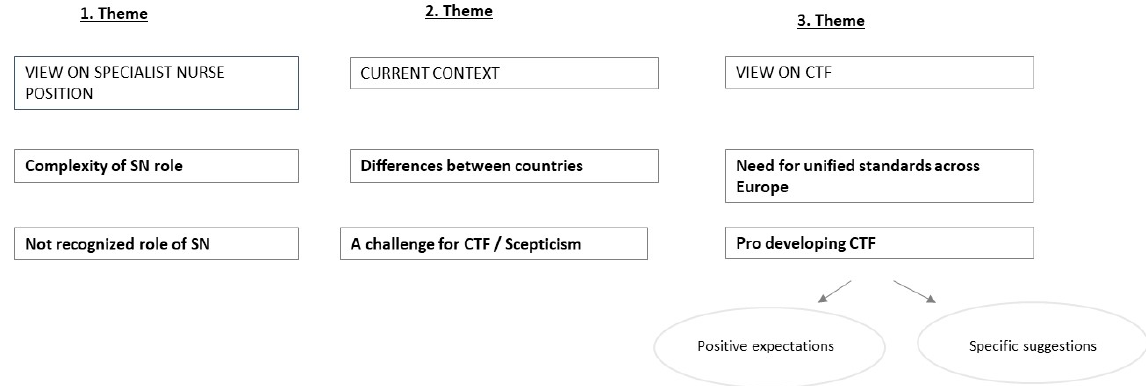
Figure 2. Summary of the findings.